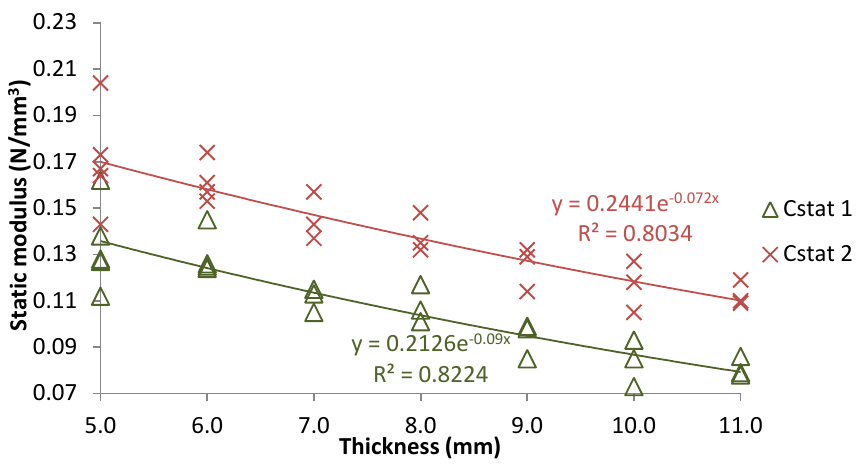
Figure 5. Influence of thickness in tire under sleeper pads (USP) static behavior.